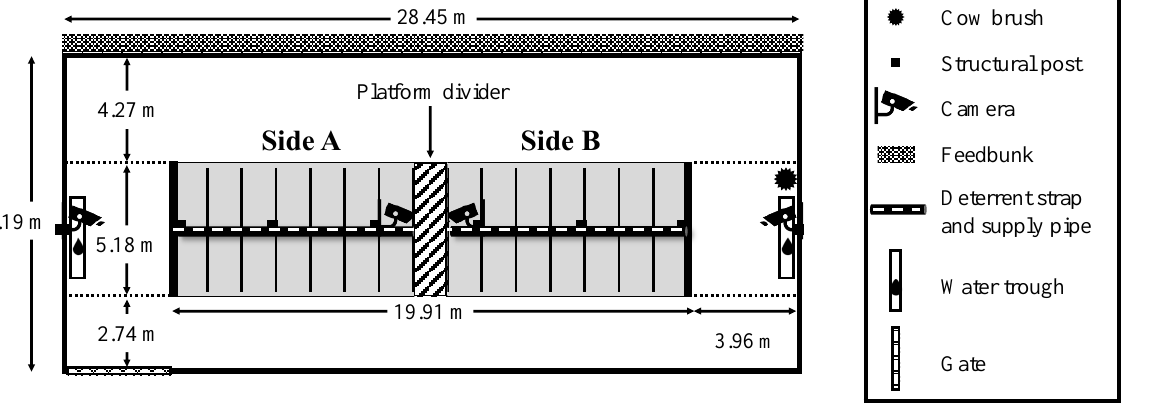
Figure 2. Layout of the experimental pen. The platform of a free-stall pen with 30 stalls was divided into two sides using an opaque divider. Fourteen second lactation dairy cows had free choice of 28 modified free-stalls. Light treatments were programmed separately per side and switched sides halfway through each treatment period. Four cameras were positioned to view each side from two different angles. A deterrent strap prevented cows from walking through the head-to-head modified free-stalls. A supply pipe containing wiring for the LED lights ran along the base of the stall platform under the deterrent strap.